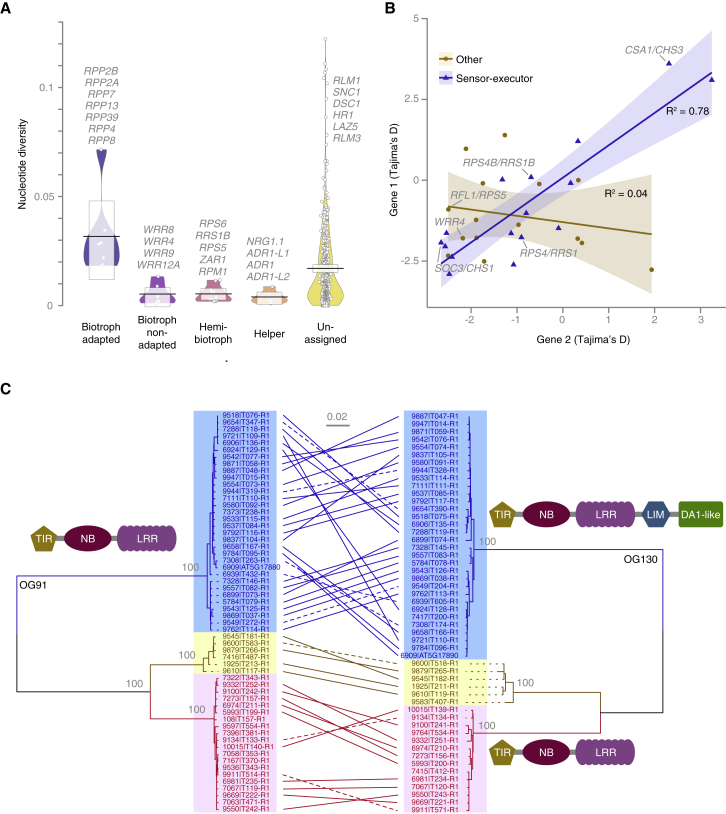
Effects of Pathogen Lifestyle on Diversity and NLR Pairing on Selection and Co-evolution(A) Effect of pathogen lifestyle on nucleotide diversity for characterized resistance genes. Gray floating text indicates examples for each category.(B) Correlation of Tajima’s D values in sensor-executor and other pairs.(C) Maximum-likelihood phylogenetic trees of two OGs 91 and 130, which form a sensor-executor pair (Xu et al., 2015). Bootstrap support (100 iterations) indicated at major nodes. OG130 includes a clade with LIM and DA1-like IDs and a clade without. Scale bar indicates substitutions per site. Genes from the same accession are connected by lines, with solid lines indicating presence on the same assembly contig.Related to Figure S6.